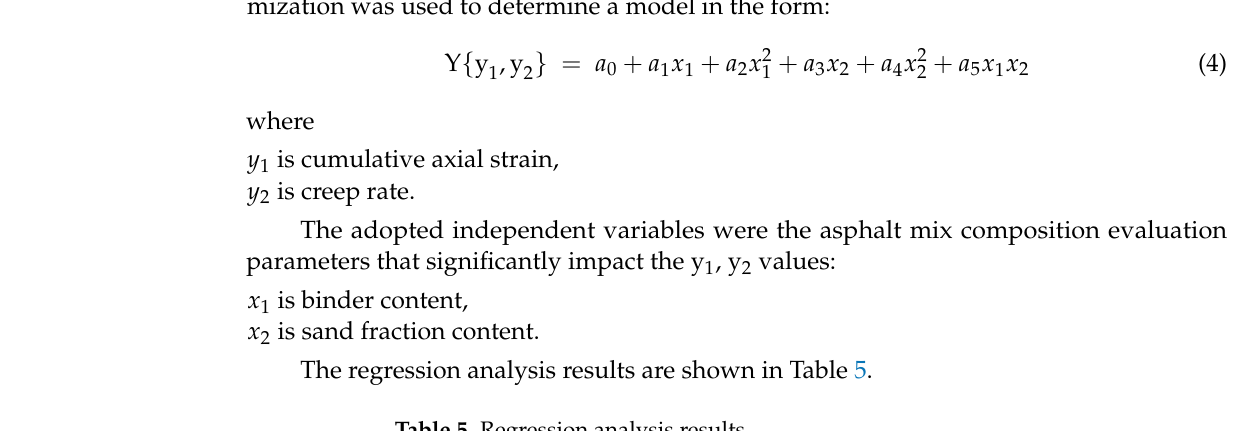
Table 5. Regression analysis results.